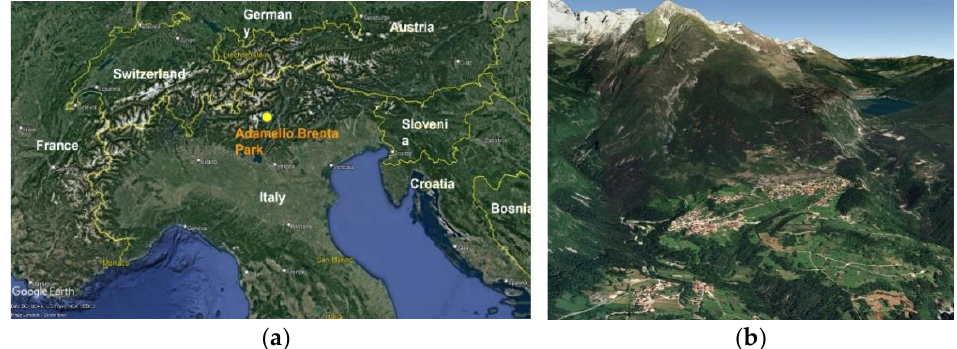
Figure 20. ( a ) The Adamello Brenta Park in the Italian territory (from Google Earth Pro V 7.3.4, (14 December 2015), 46°15′46.09″N, 10°36′00.94″E, Eye alt 1284.59 km, Terrametrics, SIO, NOAA, US Navy, NGA, GEBCO, Landsat, Copernicus 2022, GeoBasis-DE/BKG 2009, [46], modified); ( b ) the small villages at the foot of the Brenta Dolomites belonging to Adamello Brenta Geopark Park (from Google Earth Pro V 7.3.4, (19 July 2021), 46°04′33.78″N, 10°54′34.60″ E, Eye alt 2.31 km, Maxar Tech- nologies, Landsat, Copernicus, CNES, Airbus 2022, [46]).